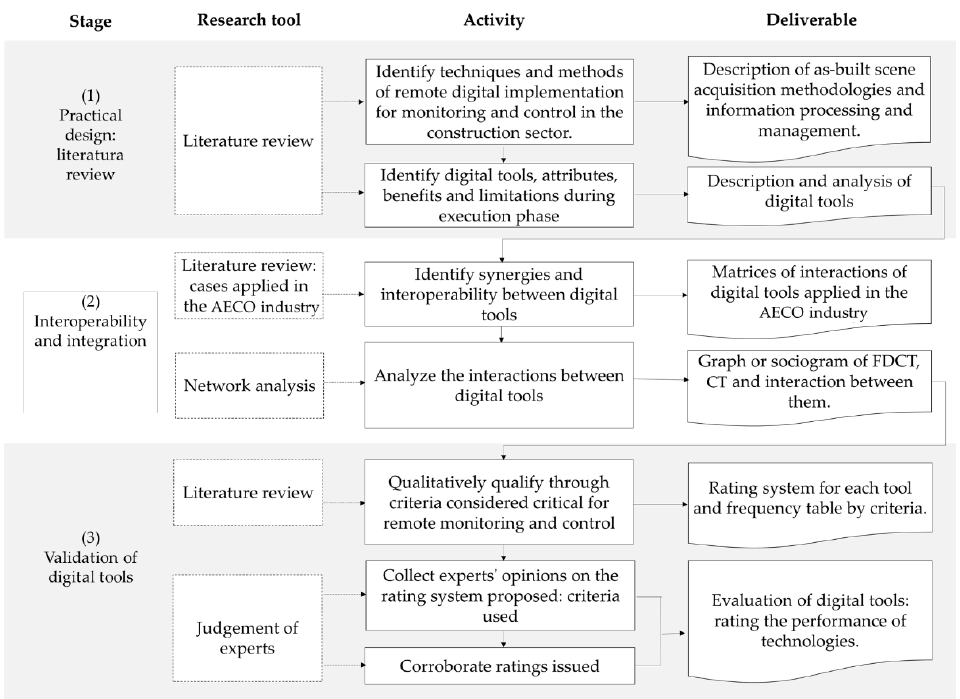
Figure 3. Three stages of the research method.